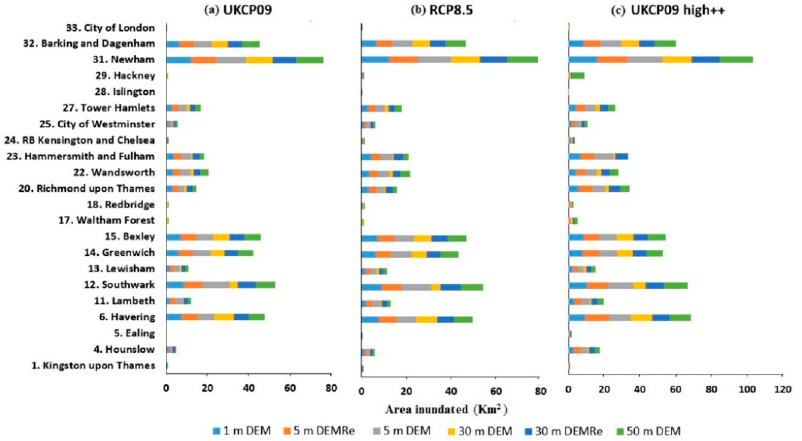
Figure 4. Inundation areas estimated for Greater London boroughs (km 2 ) obtained from a zero-connectivity method using six different DEMs and three SLR scenarios: ( a ) 0.68 m UKCP09; ( b ) 0.82 m RCP 8.5; and ( c ) 1.9 m UKCP09 High++.